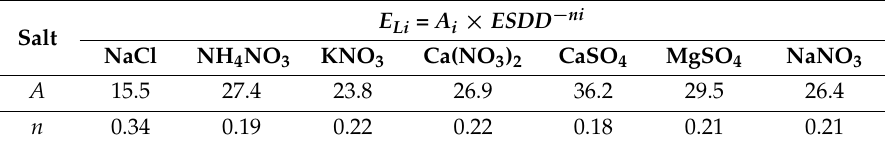
Table 5. Fitting results of insulator flashover gradient with different soluble constituents